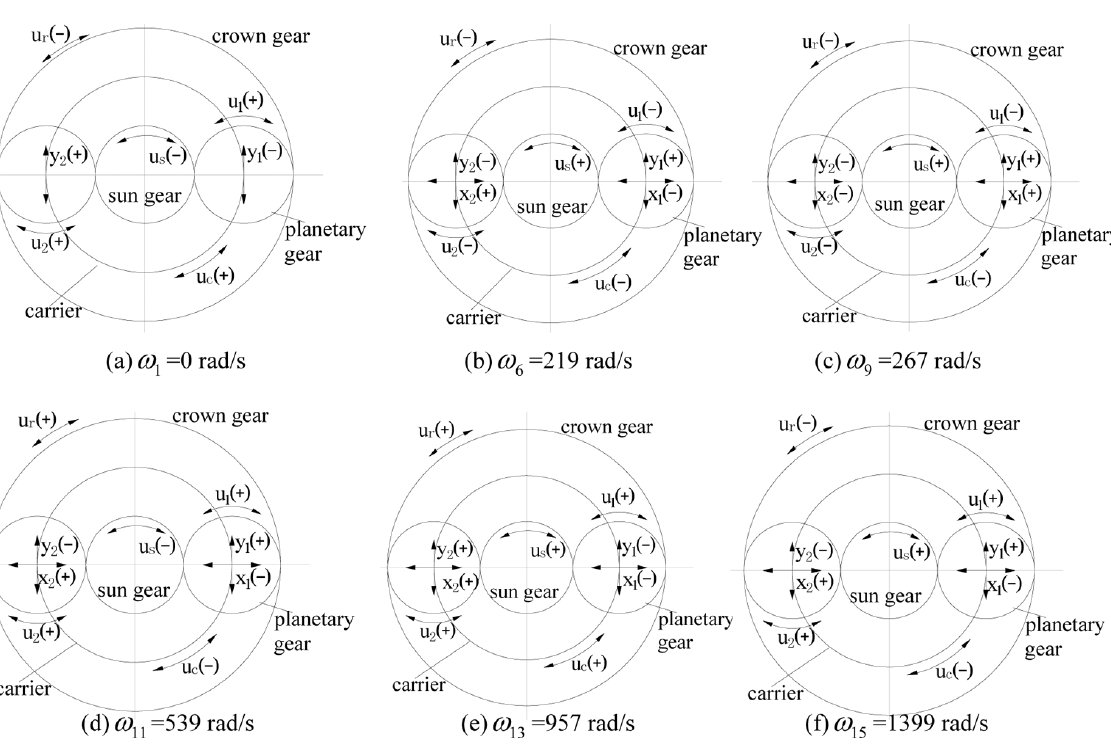
Fig. 7. Torsion modes of the central elements ( N =